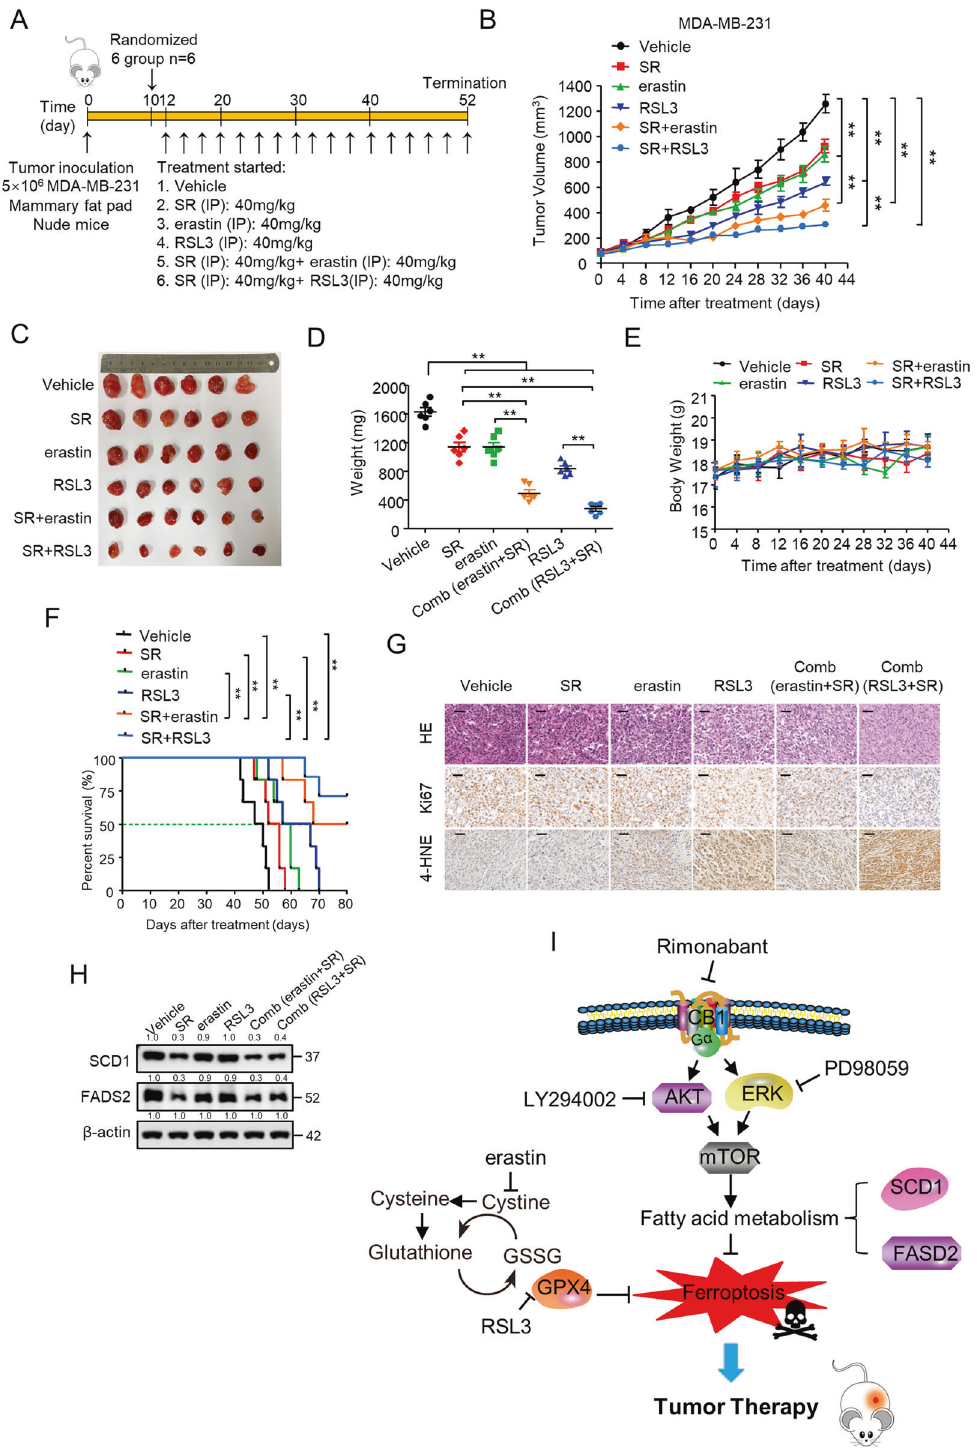
Fig. 6 Rimonabant combined with erastin/RSL3 signi fi cantly repressed TNBC tumor growth in vivo. A Treatment schedule for the MDA- MB-231 cells orthotopic implantation model was treated with vehicle, rimonabant (SR), erastin and RSL3 as single agents or drug combinations. B – D Mice were treated as ( A ) 12 days after xenograft, and tumor size was monitored every other day B . Photograph of tumors ( C ) and tumor weight ( D ) are shown ( n = 6 per group). ** p < 0.01 (one-way ANOVA). E Body weight of BALB/c nude mice treated as ( A ) were shown ( n = 6 per group). F Survival rates for nude mice treated as in ( A ) were shown (log-rank test; n = 6 per group). ** p < 0.01 (Kaplan – Meier). G Representative images of H&E, Ki-67 and 4-HNE IHC staining in harvested tumors from each group were shown. Scale bars represent 50 mm. H WB analysis of SCD1 and FADS2 in harvested tumors from each group were shown. I Proposed model for CB1 regulated SCD1- and FADS2- dependent fatty acid metabolism via PI3K-AKT and MAPK signaling pathways to inhibit TNBC cell growth. Data shown are the means ± SD from six tumors at each time